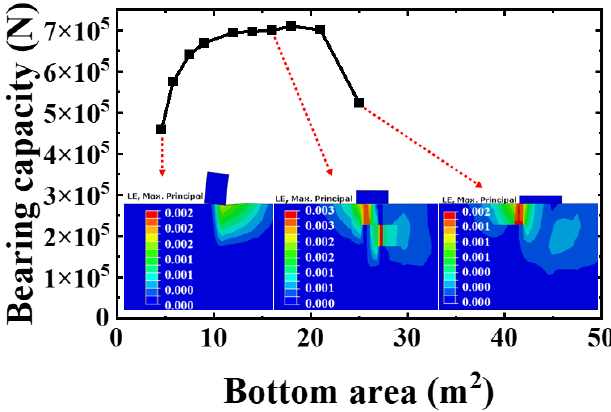
Figure 18. Anchor bottom area and bearing capacity curve.